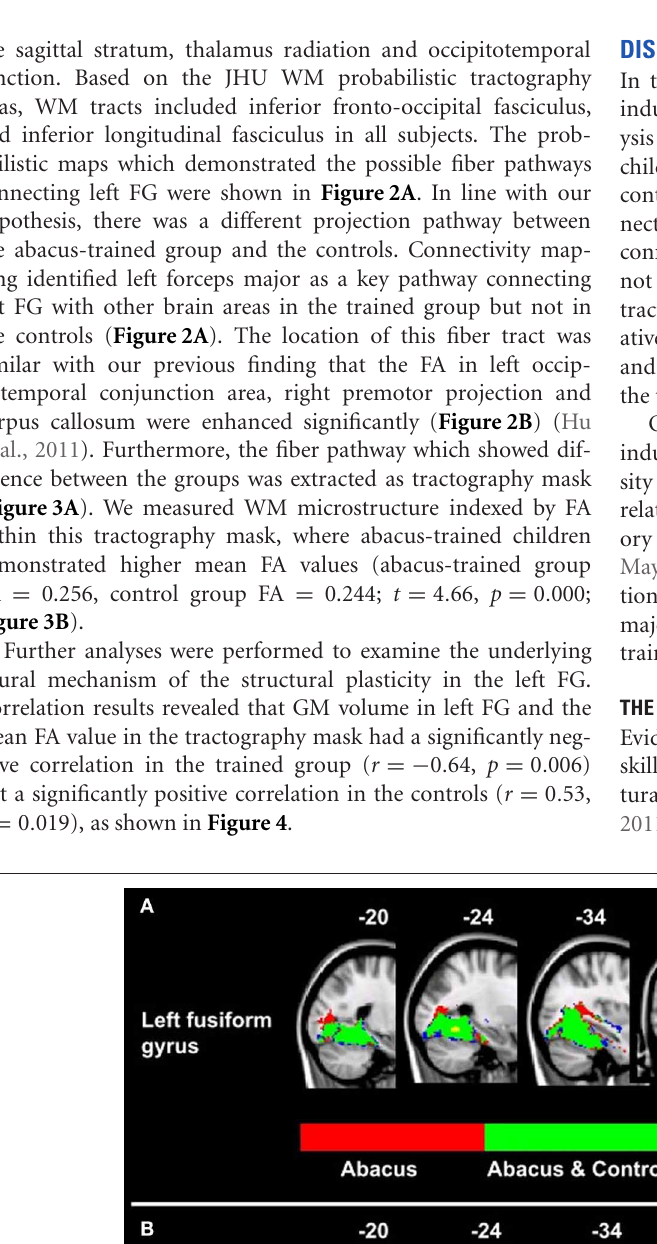
the abacus-trained group using TBSS method (Hu et al., 2011). The statistical map was overlapped onto the mean FA skeleton (green) and MNI152 template (gray-scale). The FA in left occipitotemporal conjunction area, right premotor projection and corpus callosum were enhanced significantly. The location of left occipitotemporal conjunction area was marked by blue circle. L,